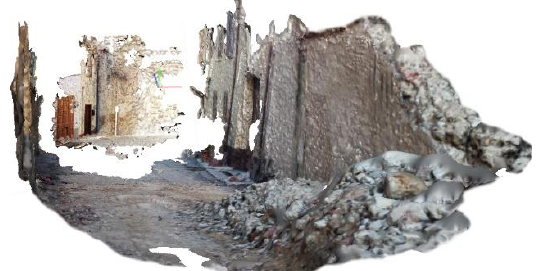
Figure 6. 3D reconstruction of a fragment of Norcia city centre At times, despite the images being frontal and rich in information